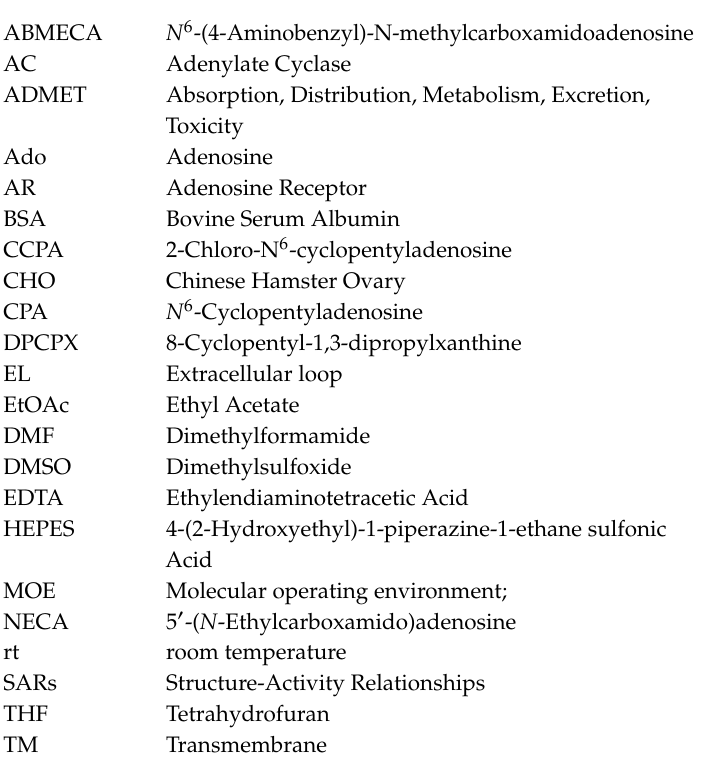
Table S2. Calculated molecular properties and ADMET parameters for compound 3